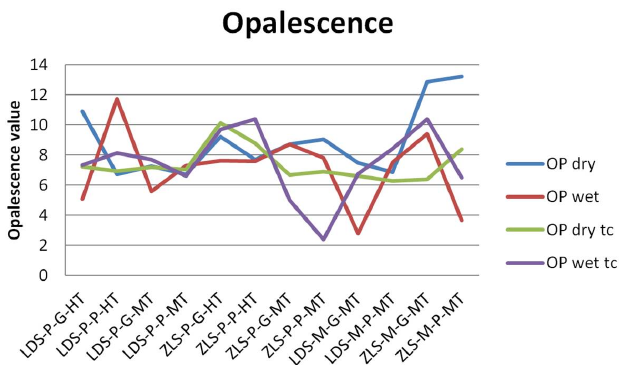
Figure 4. Results of the opalescence measurements before and after thermocycling.